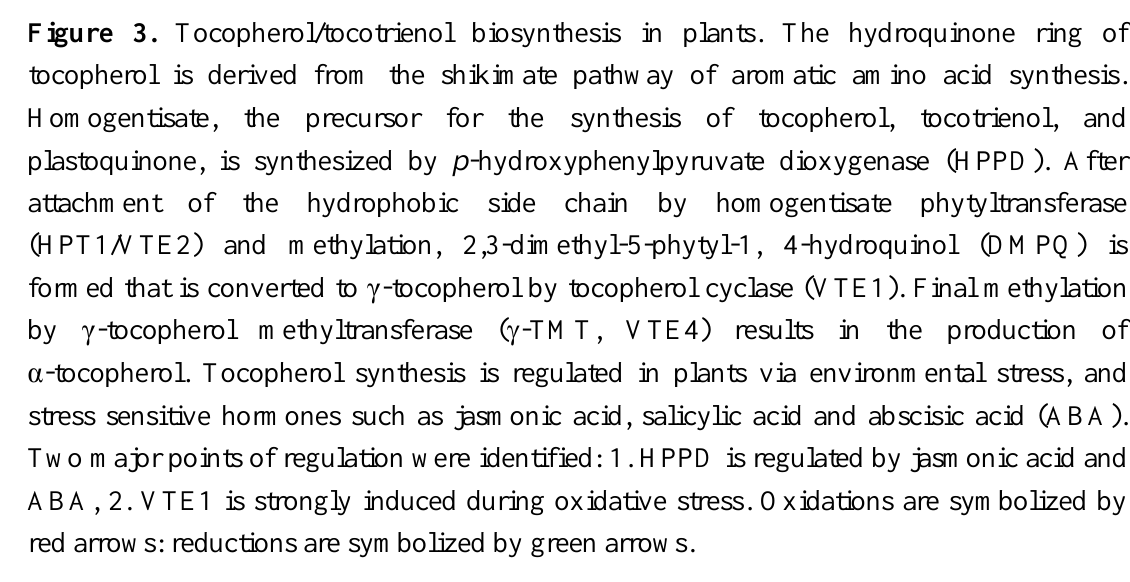
Figure 3. Tocopherol/tocotrienol biosynthesis in plants. The hydroquinone ring of tocopherol is derived from the shikimate pathway of aromatic amino acid synthesis. Homogentisate, tocotrienol,